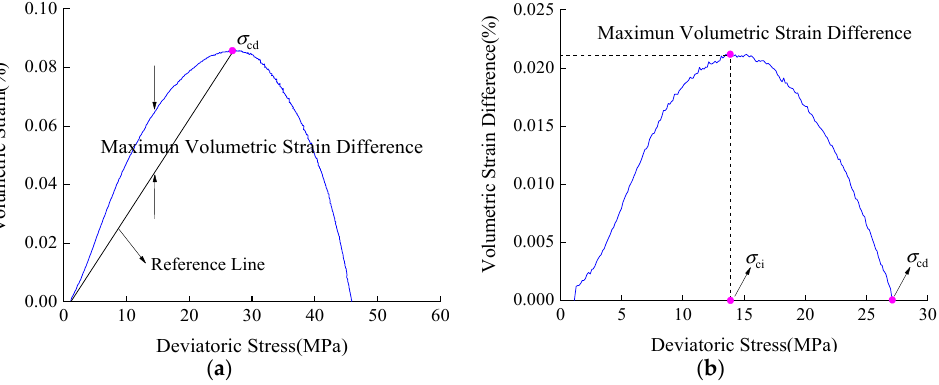
Figure 6. The value of σ ci is determined based on the volume strain difference–deviatoric stress curve and reference line: ( a ) creating the reference line and ( b ) determining the σ ci value.